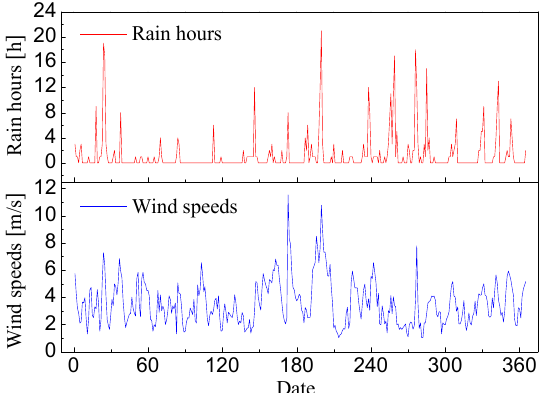
Figure 8. Daily variation curves of average wind speeds and total rain hours in Xisha.